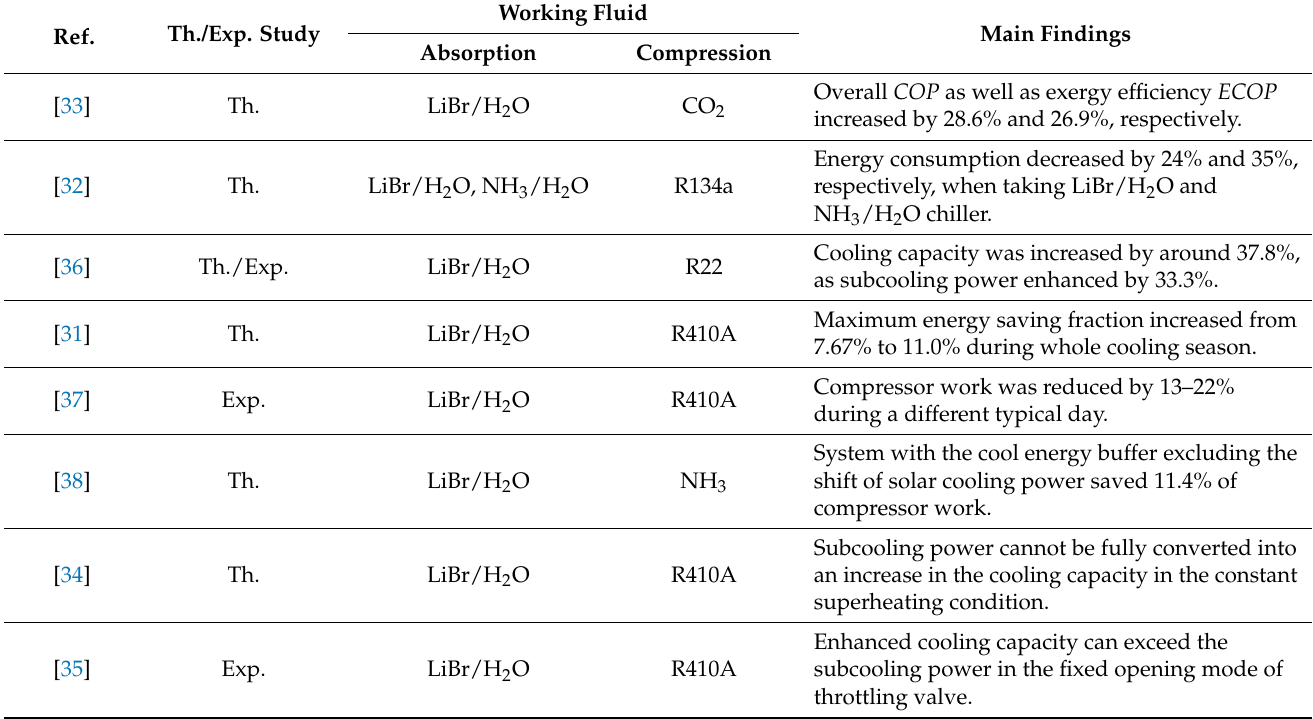
Table 3. Summary of literature survey on cooling systems with cascade subcooling process.